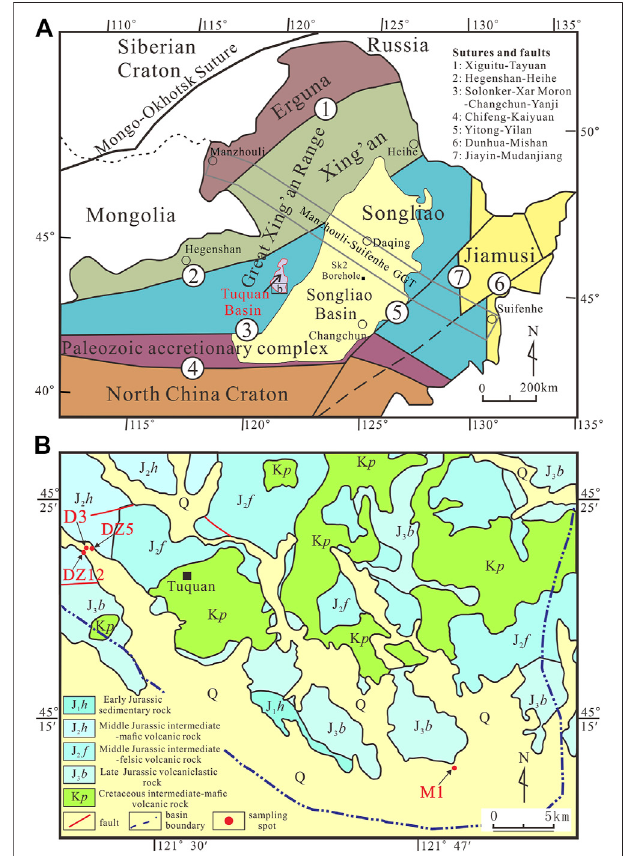
FIGURE 1 | (A) Tectonic subdivisions of northeastern China and the location of the Tuquan Basin (modi fi ed after Wu et al., 2011). GGT indicates Global Geosciences Transect. (B) Simpli fi ed geological map of the Tuquan Basin showing sample locations modi fi ed after Inner Jilin Bureau of Geology and Mineral Resources